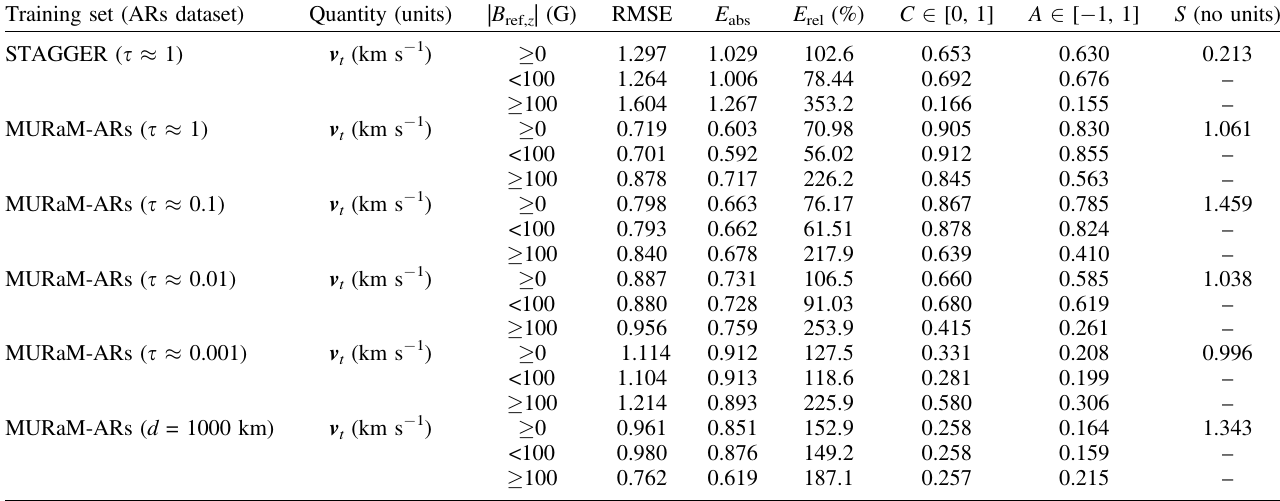
Table 3. Comparison between fl ow fi elds v D , t and v ref, t for the ARs dataset. RMSE is the root mean squared error (Eq. (1)), E abs is the mean absolute error (Eq. (2)), E rel is the mean relative error (Eq. (3)), C is the correlation coef fi cient (Eq. (4)), A is the spatially-averaged normalized dot product (Eq. (5)) and S is the ratio between the integrals of the unsigned shear components of the DeepVel and reference Poynting fl uxes (Eq.